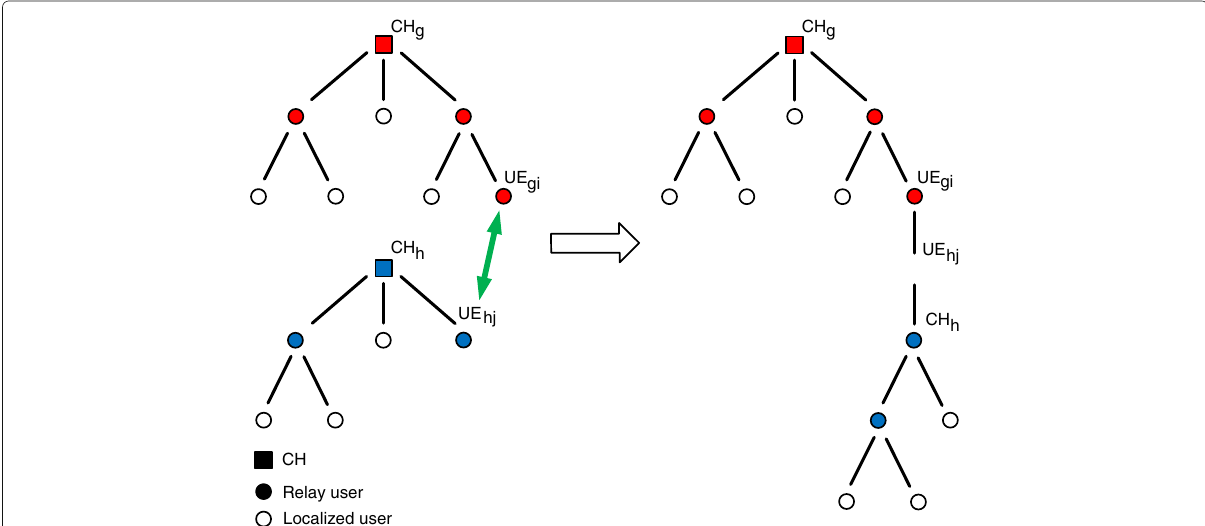
Fig. 13 UWB coverage extension. This figure represents the case where a relay from group g detects a relay belonging to group h . This means that there may be one hotspot instead of two. In such a case, relay from group g and h will compare their hops with their corresponding CH, and the one with less number of hops will change group. Automatically, all the UEs attached to the relay that just made a group change will belong to the new group